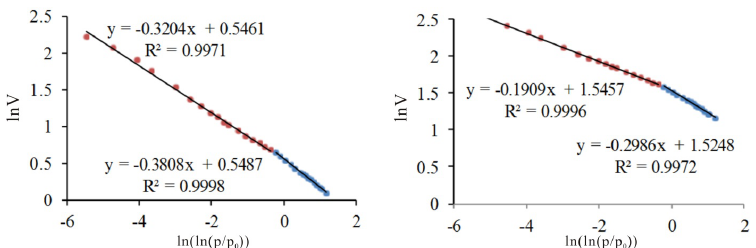
Figure 6. Plots of lnV vs. ln(ln(P 0 /P)) obtained from the N 2 adsorption isotherms of two typical shale samples: ( a ) sample 7 and ( b ) sample 15. In Figure 6a,b, red dots indicate the P/P 0 range of 0.5‒1, and blue dots indicate the P/P 0 range of 0‒0.5. Table 7. Fractal dimensions of pores obtained from N 2 adsorption of the shale samples.